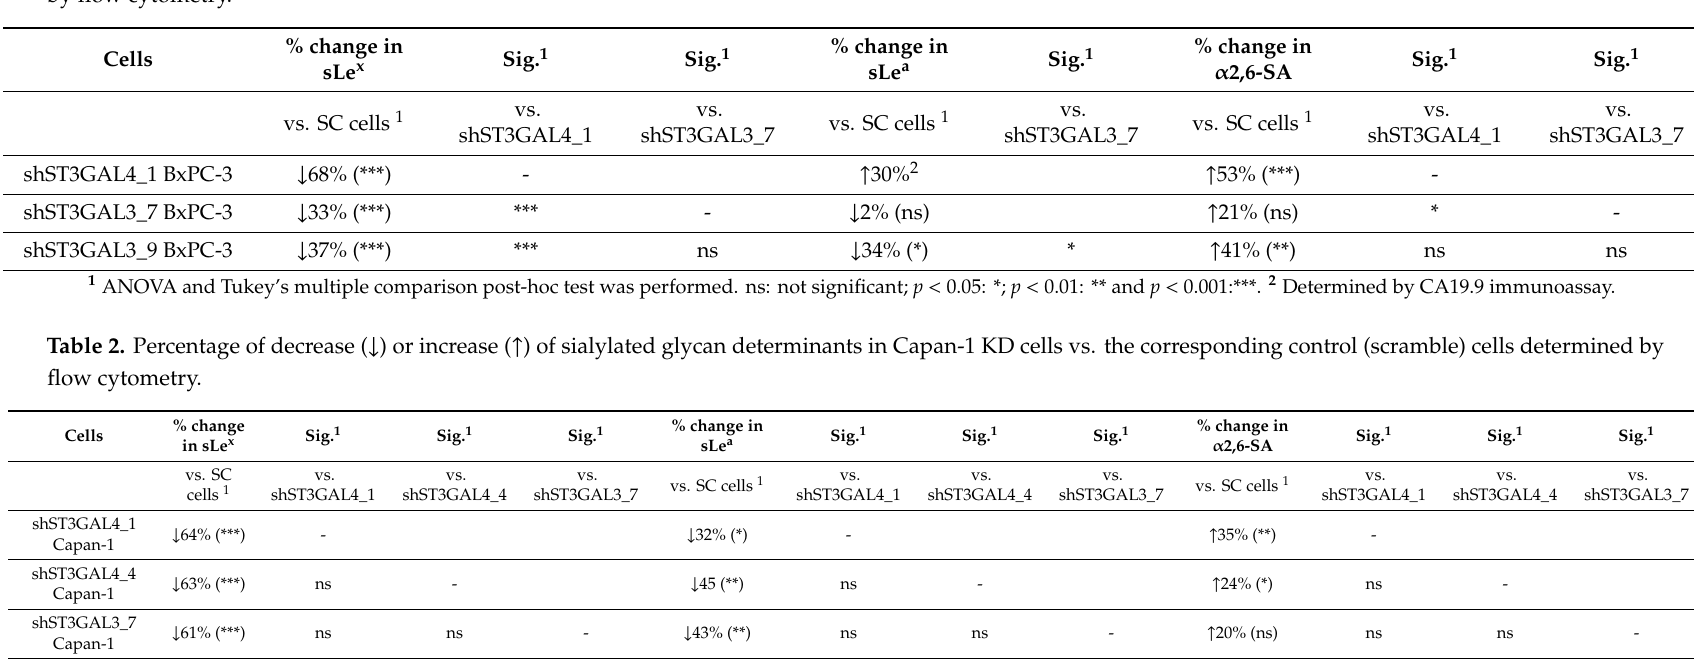
Table 1. Percentage of decrease ( ↓ ) or increase ( ↑ ) of sialylated glycan determinants in BxPC-3 KD cells vs. the corresponding control (scramble, SC) cells determined by flow cytometry.